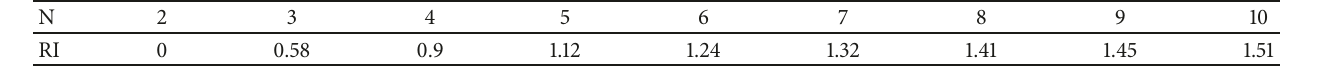
Table 6: Number of attributes and random index.